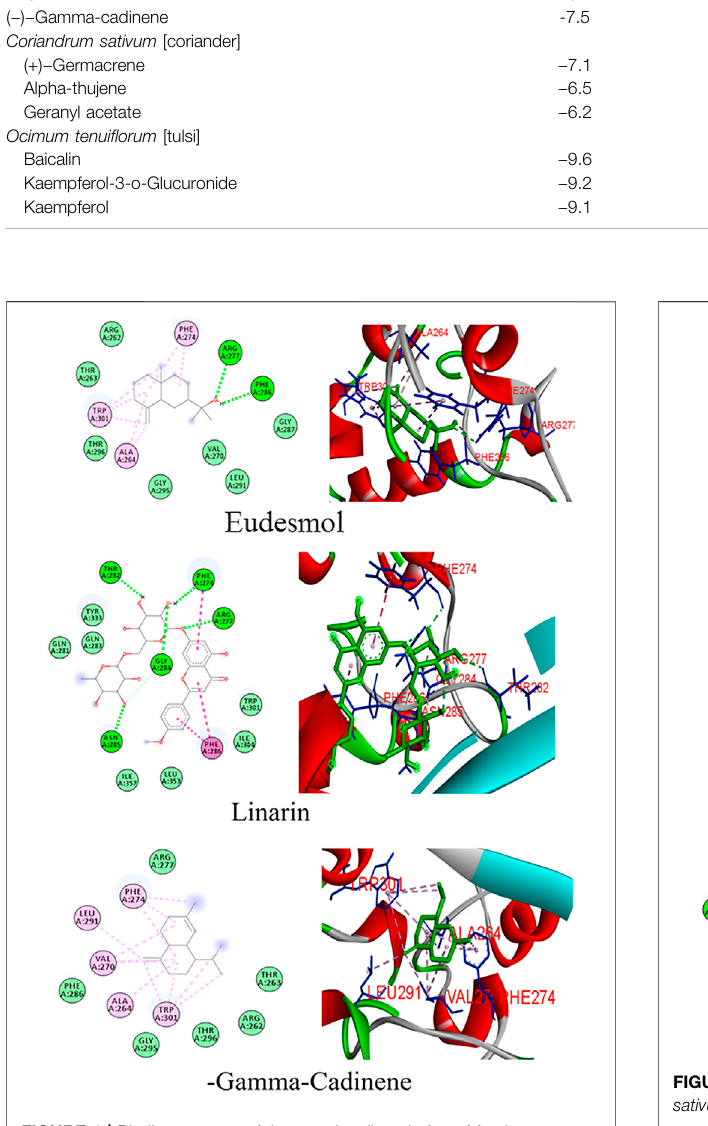
FIGURE 1 | Binding patterns of the top phytoligands from Mentha arvensis against the N protein.